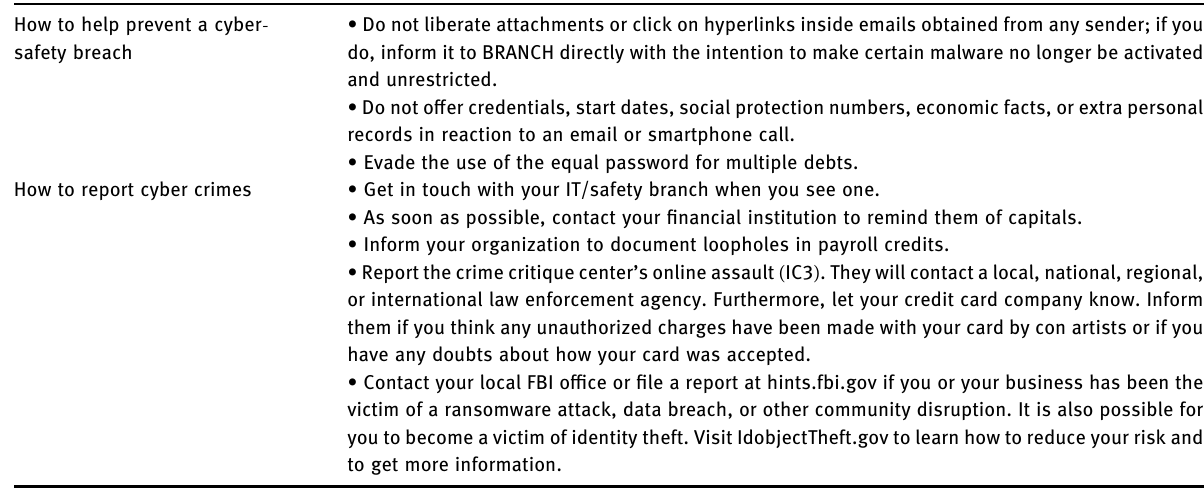
Table 4: Prevention from various data/safety breaches How to help prevent a cyber